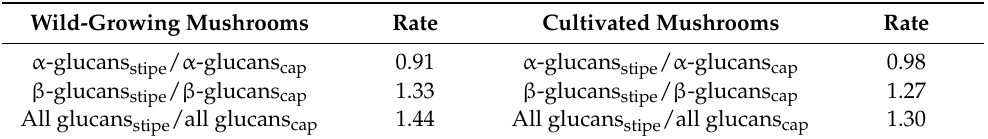
Table 7. Glucan rates from stipes and caps in wild-growing ( n = 23) and three cultivated mushrooms, analyzed on data of